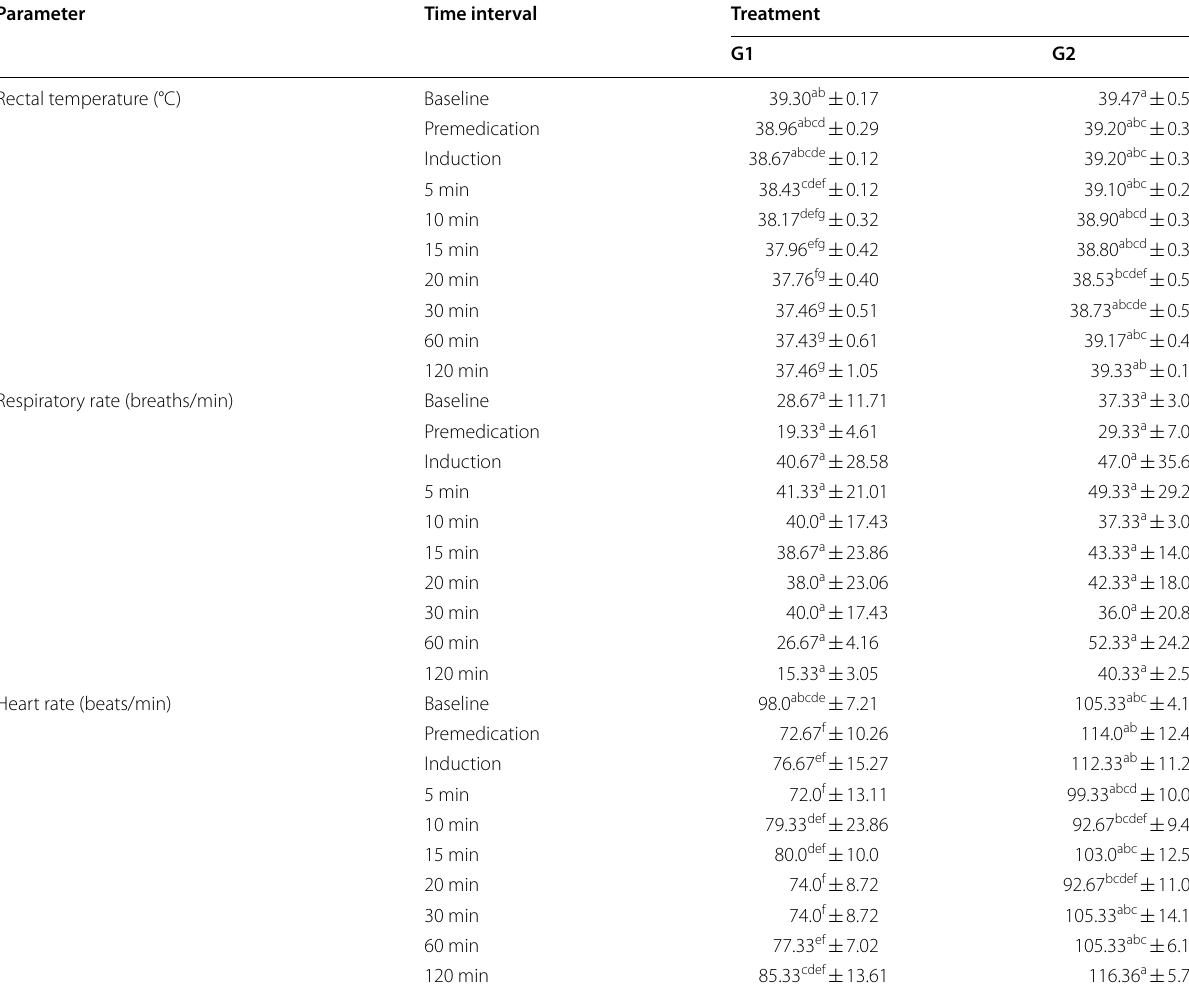
Table 5 Mean standard deviation (SD) of physiological parameters at different time intervals ±